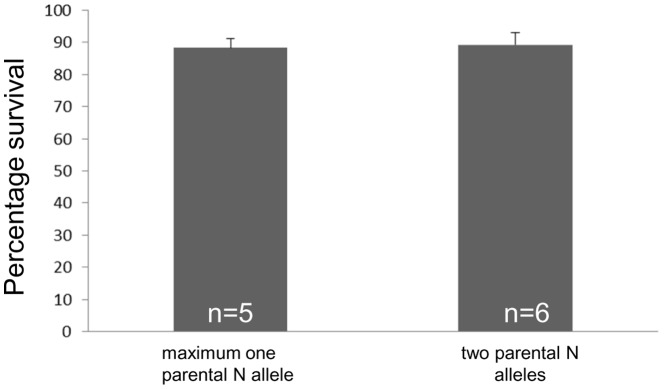
The survival rates from crosses with two nude/linear parents and those with only one were not different.All brooders were of European origin. Survival percentage was measured on seventh day post hatching and calculated as live fry number/total egg number. Three to five technical replicates per sample were counted. The difference between the two groups is not statistically significant (Student's t-test; P = 0.63).